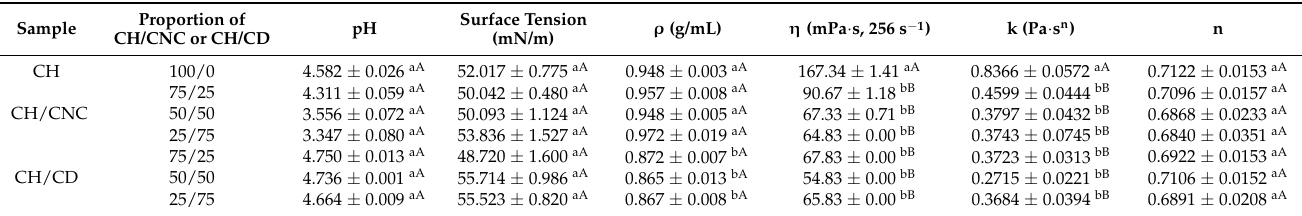
Table 1. Physicochemical properties of CH, CH/CNC and CH/CD primary solutions.